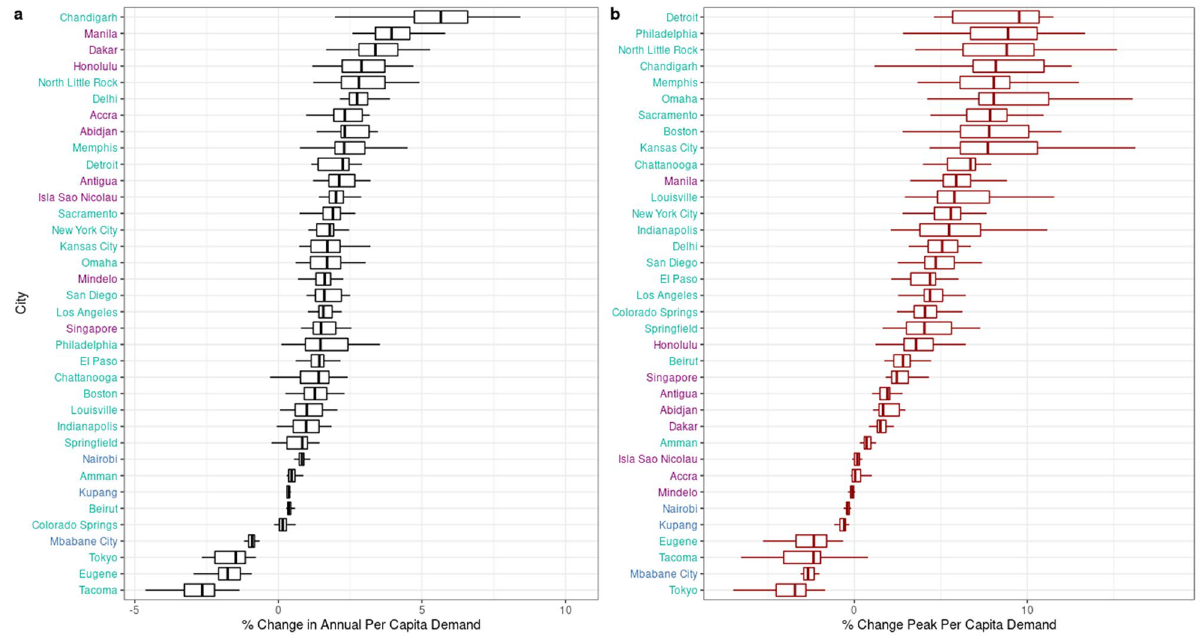
Figure 4. Percentage change in ( a ) total annual and ( b ) 95th percentile demand due to changes in hourly temperatures circa 2050, 21 GCM simulations of RCP 8.5